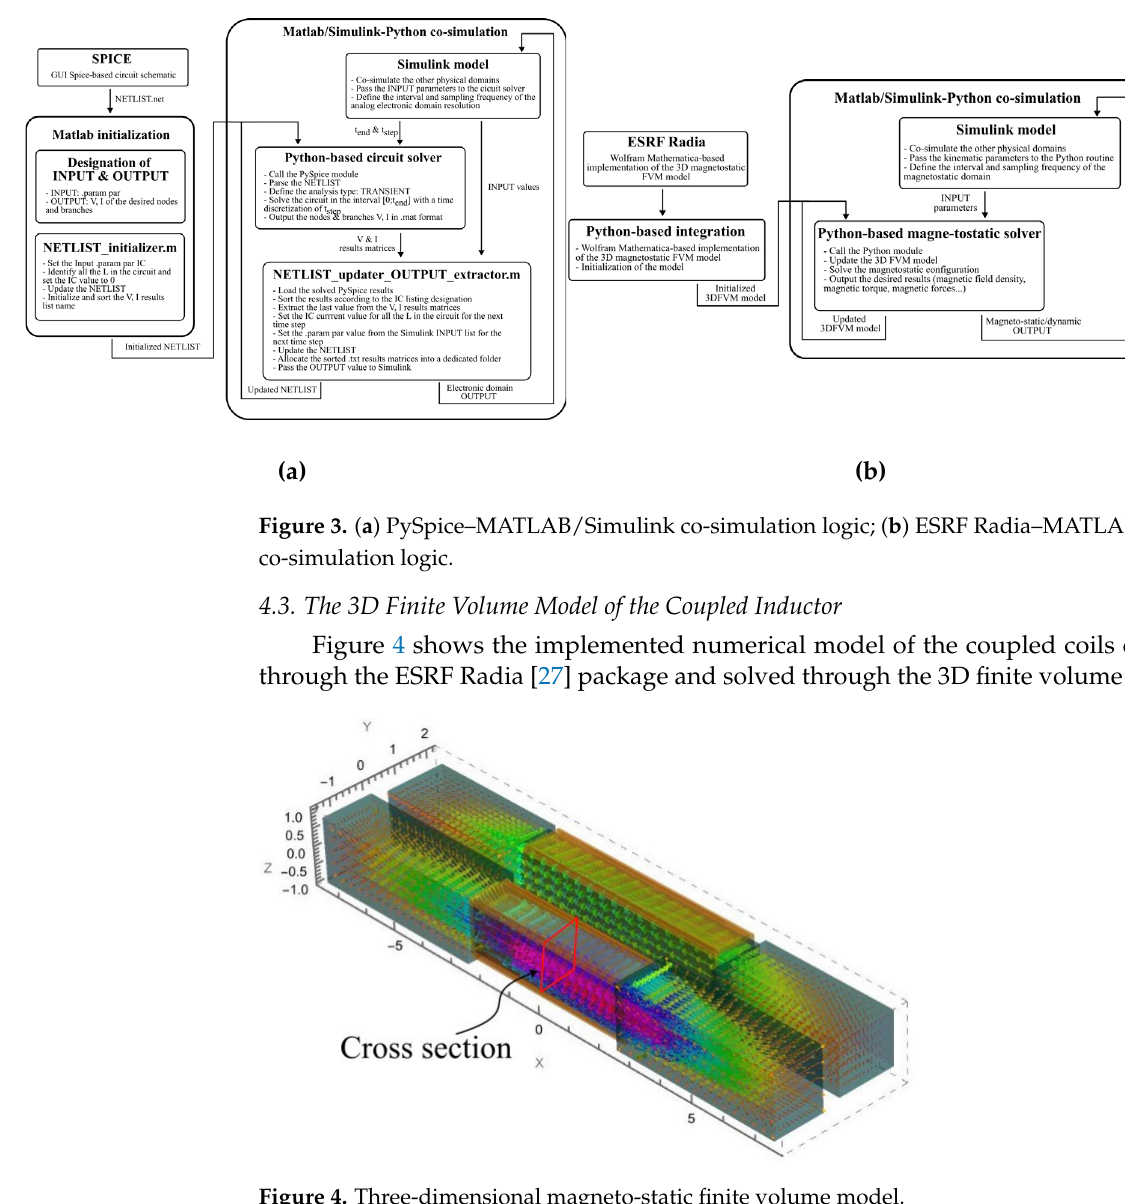
Figure 4. Three-dimensional magneto-static finite volume model.